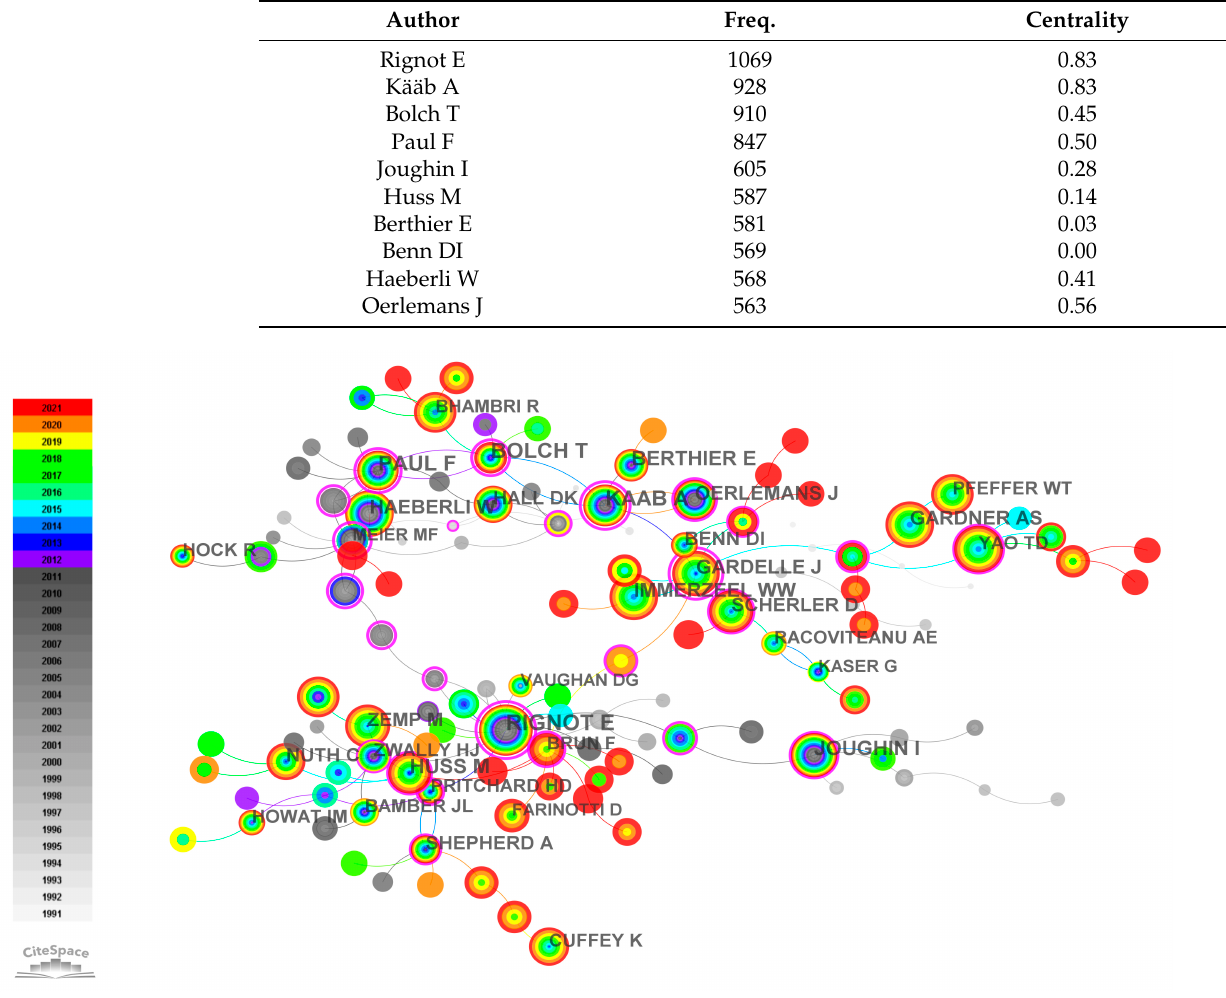
Table 4. Top ten productive authors.